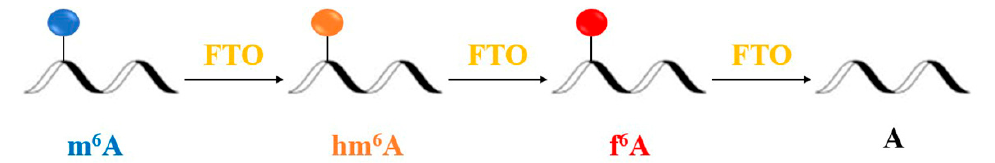
Figure 6. Schematic diagram of the process of FTO demethylates m 6